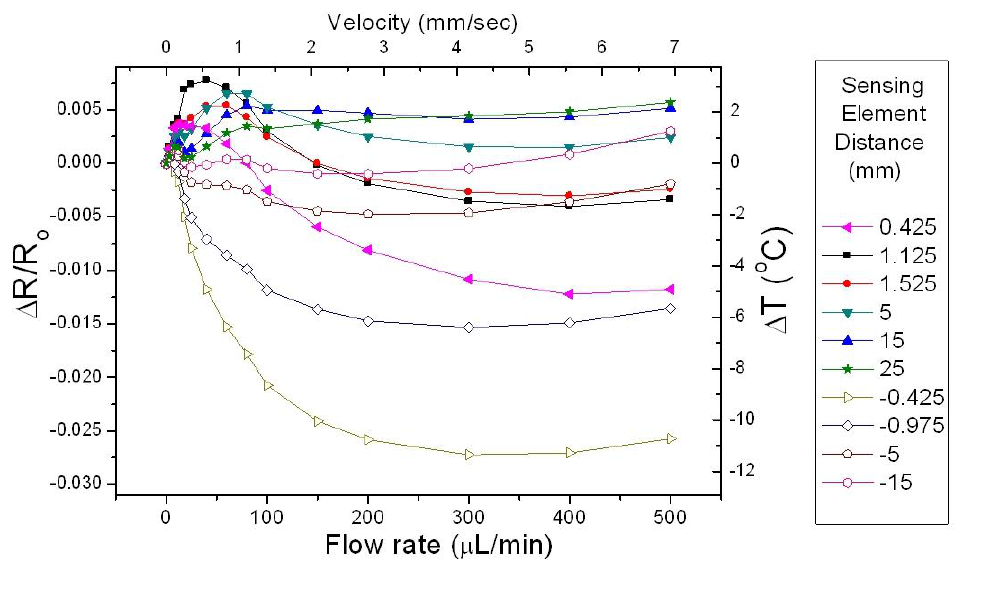
Figure 6. Normalized resistance change of the sensing elements situated in various distances from the heater as a function of the flow rate. The liquid used was water, while the tube crossectional area was 1.2 mm 2